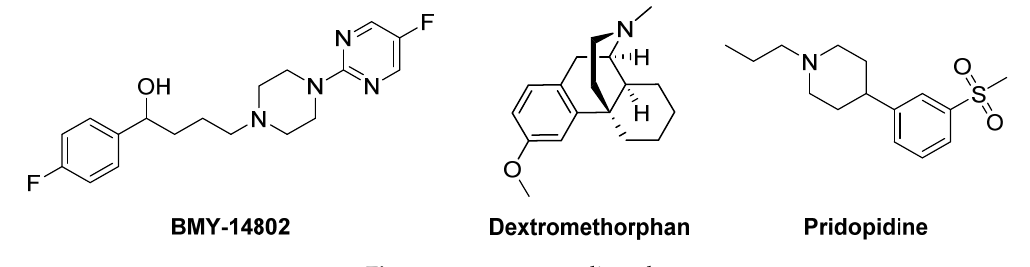
Figure 18. σ 1 receptor ligands.